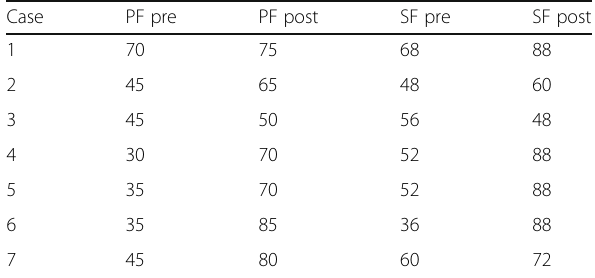
Table 2 Physical function (PF) and social/well-being function (SF) patient scores pre- and post-operation Case PF pre PF post SF